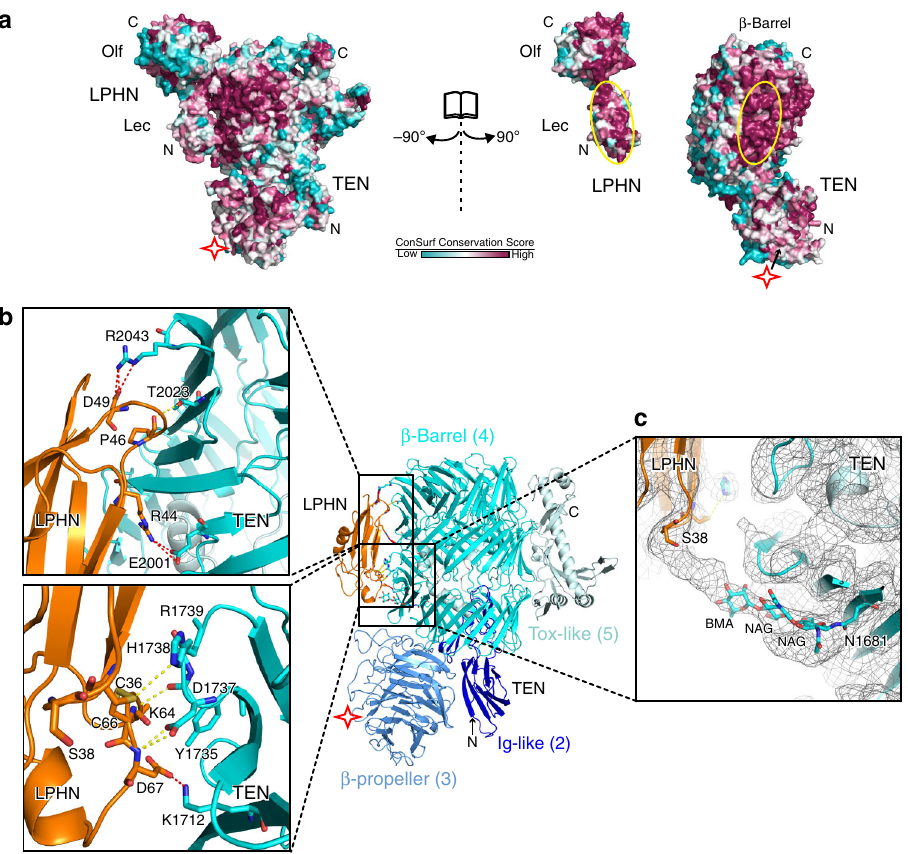
Fig. 3 TEN2 and LPHN3 interaction is mediated by conserved residues. a The TEN2/LPHN3 binding interface is conserved. The structure of the TEN2/ LPHN3 complex is shown in surface representation on which the conservation of residues is mapped from most conserved (magenta) to least conserved (cyan) (using the ConSurf server 63 ). The LPHN-binding site on TEN2 and the TEN2-binding site on LPHN3 are indicated by yellow circles. b Ribbon diagram of the TEN2/LPHN3 heterodimer showing the interface between TEN2 and LPHN3. Close-up view of the binding interface shows tentative residues involved hydrogen bonds and salt bridge shown by yellow dashes and red dashes, respectively. The TEN2 mutation DHR mutation (D1737N, H1738T, R1739T) which disrupt the TEN2/LPHN3 are shown as sticks. Two salt bridges between R44 and E2001; two between D49 and R2043; one between D49 and R2043; and one between D67 and K1712 are observed. c Close-up view for the EM density showing the close packing of the conserved N-linked glycosylation on TEN2-N1681 with LPHN3-S38 on the Lec domain. Due to the uncertainty of the glycan topology, we only modeled the fi rst three sugars of N-glycosylation (NAG-NAG-BMA) into the